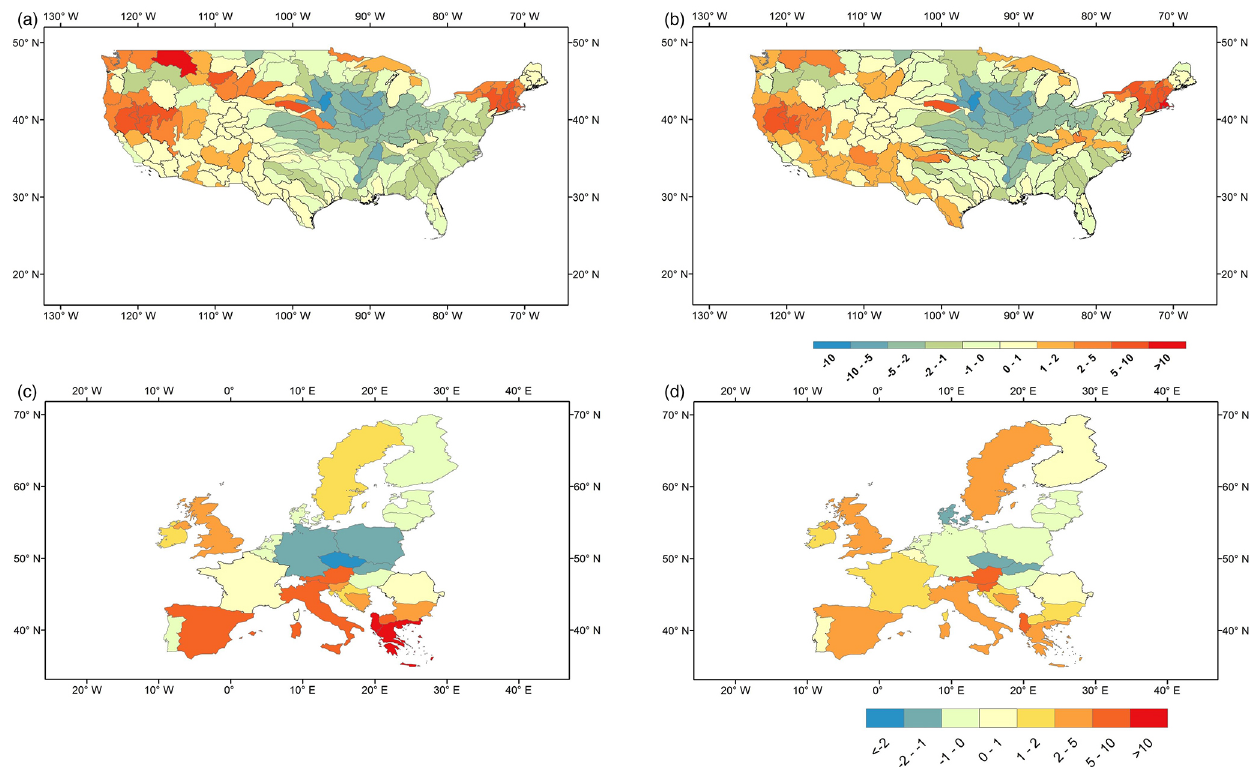
Figure 9. (Top) Difference plots between soil erosion estimates from the NRI database for the USA and estimates of (a) the unadjusted RUSLE model, and of (b) the adjusted RUSLE model, all aggregated at HUC4 watershed level. (Bottom) Difference plots between soil erosion estimates from the database of Cerdan et al. (2010) for Europe and estimates of (c) the unadjusted RUSLE model and of (d) the adjusted RUSLE model, all aggregated at country level. Reddish colours represent an overestimation (tha − 1 year − 1 ) while the bluish colours represent and underestimation (tha − 1 year − 1 ) compared to the erosion values from the